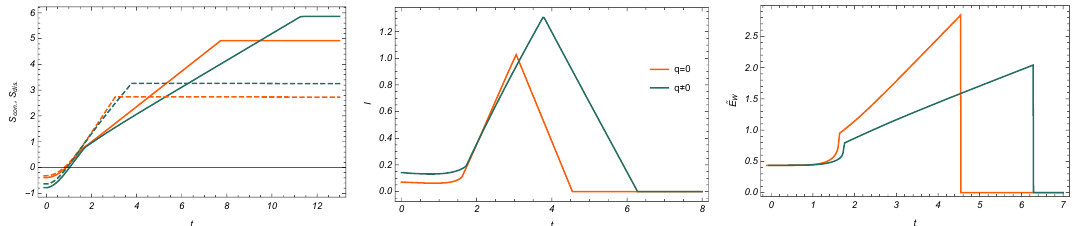
Figure 15 . Comparison of the time evolution of the HEE (left), HMI (middle) and EWCS (right) for neutral and charged quenches. Clearly when there is charge density, the equilibration process becomes less e(cid:14)cient. Here we have set h = 2 : 2 ; ‘ = 4 :